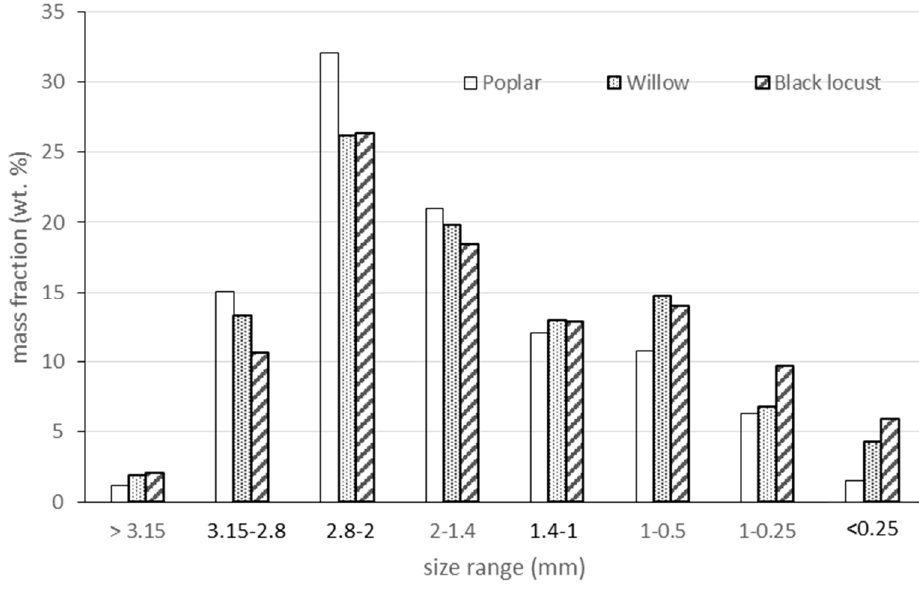
Figure 2. Particle size distribution.